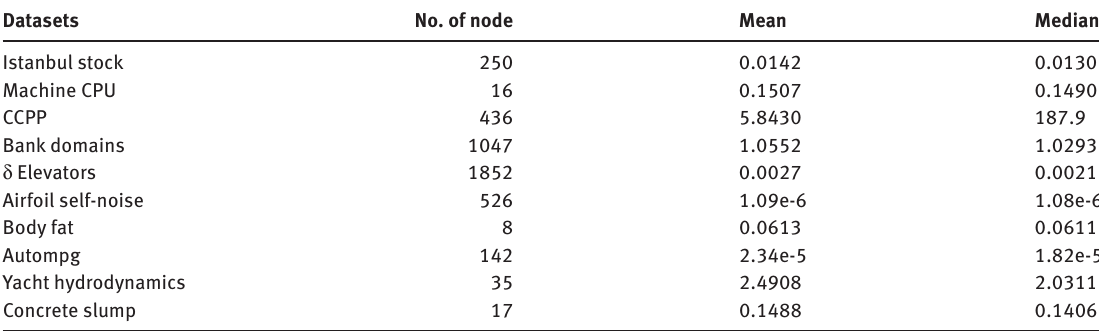
Table 4: The Performance Comparison between Mean and Median of ELM Training Error.